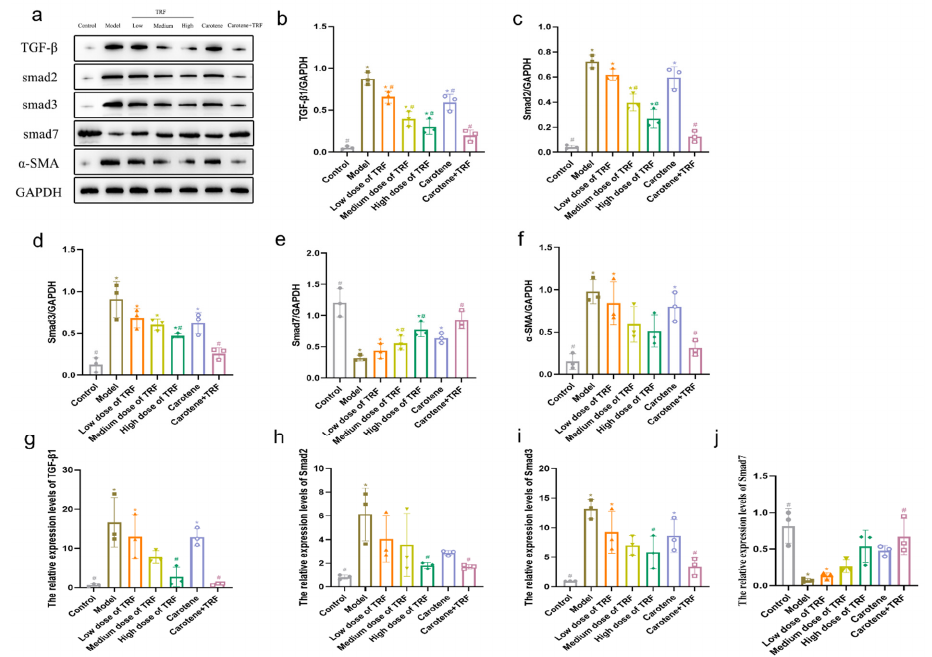
Figure 6. TRF and carotene protected against pulmonary fibrosis via the inhibition of the TGF- β /Smad signaling pathway: ( a – f ) TRF and carotene decreased the expression of fibrosis proteins induced by BLM in SD rats. The protein expressions of ( b ) TGF- β 1, ( c ) Smad2, ( d ) Smad3, € Smad7, ( f ), and ( g ) α -SMA in the lung samples were examined by Western blotting analysis; n = 3; ( g–j ) representative statistical analyses of ( g ) TGF- β 1, ( h ) Smad2, ( i ) Smad3, and ( j ) Smad7 mRNA by RT-qPCR; n = 3. Note: compared with CON group, # represents p < 0.05; compared with MOD group, * represents p < 0.05.